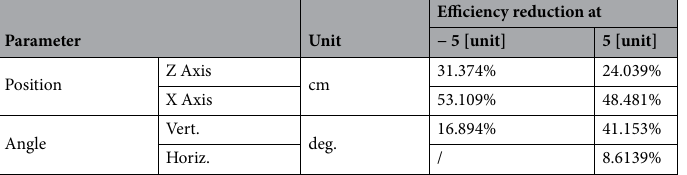
ˆ X axis. ( b ) Attitude parameters’ influence on the